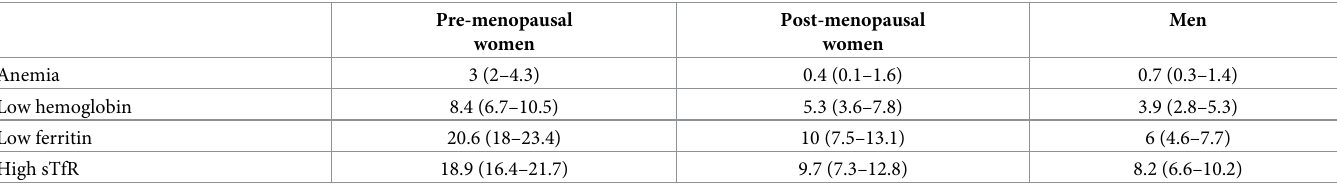
Table 2. Percentage of donors with abnormal hemoglobin, ferritin or sTfR